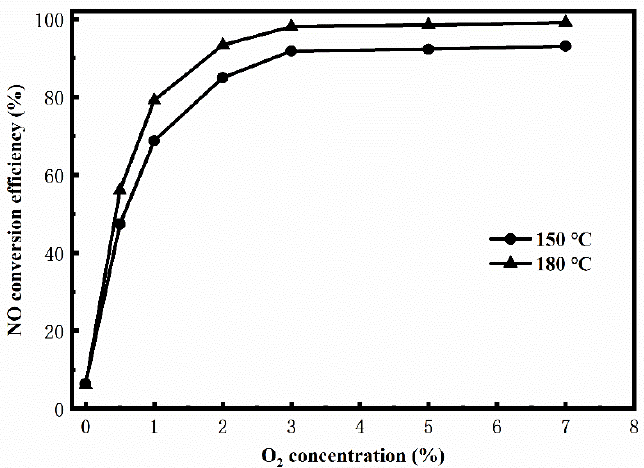
Figure 4. Effect of O 2 concentration on NO conversion of Mn10Ce41/NG catalyst.